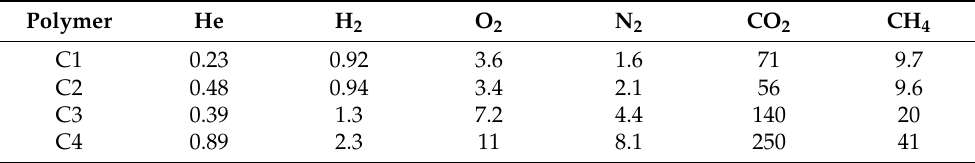
polymers at (21 ± 2 ◦ C), calculated as